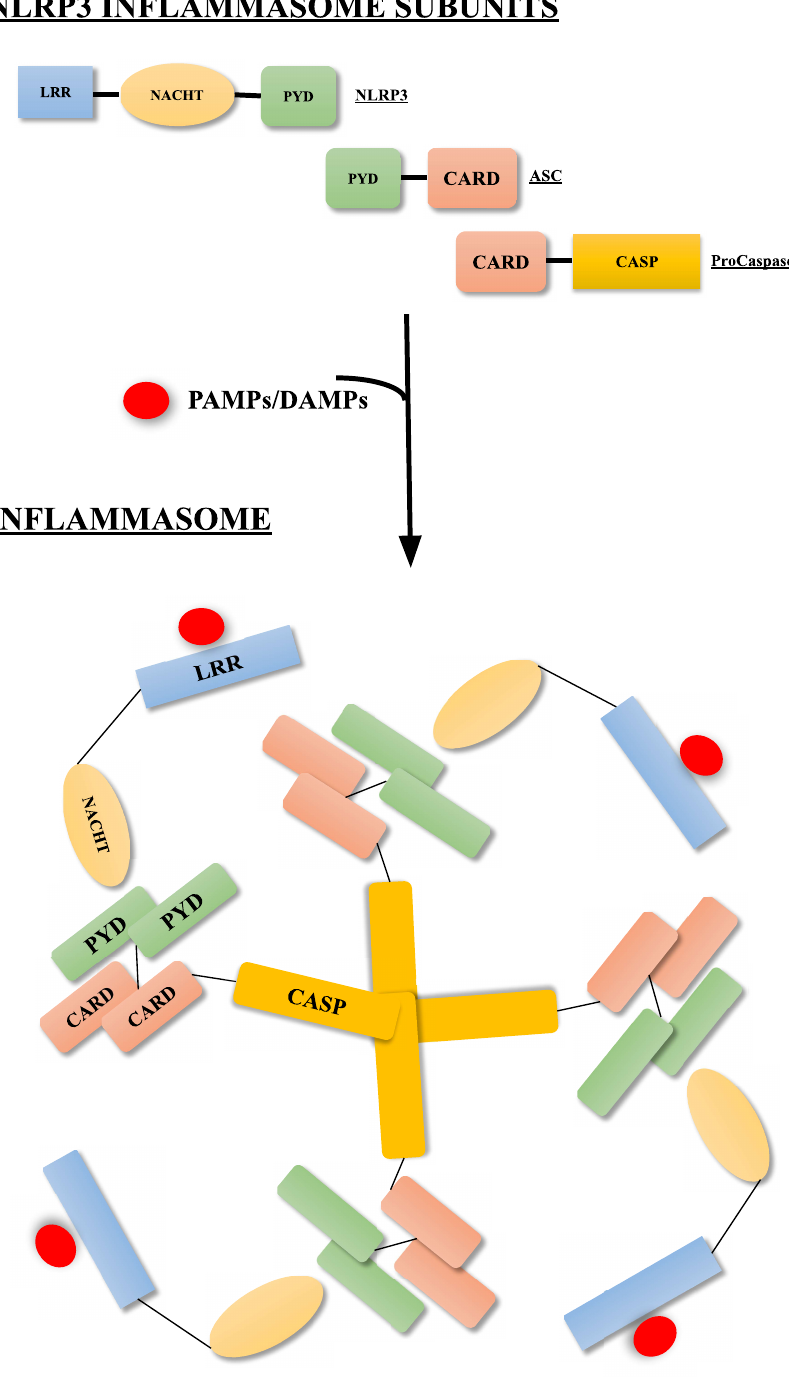
Figure 1. NRLP3 inflammasome subunits and their subsequent oligomerization after binding with PAMPs or DAMPs, as pathogens or intracellular danger signals. The NLRP3 inflammasome is a multiprotein complex including NLRP3, ASC and pro-caspase 1 domains. Following interaction with PAMPs and DAMPs, it undergoes oligomerization, through the binding to ASC and then caspase-1 precursors. Adaptor protein apoptosis-associated speck-like protein (ASC); caspase-activation recruit- ment domain (CARD); amino-terminal pyrin domain (PYD), nucleotide-binding domain (NACHT); carboxy-terminal leucine-rich repeat (LRR); caspase 1 (CASP); damage-associated molecular patterns (DAMPs); pathogen-associated molecular patterns